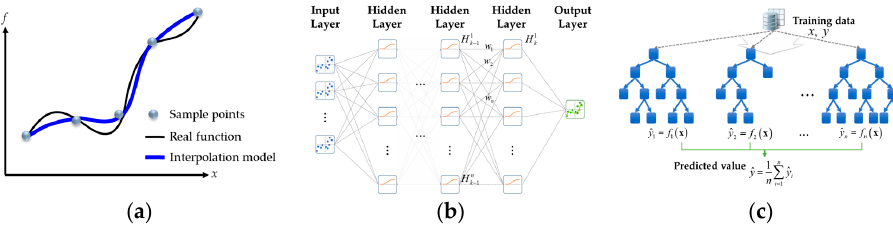
Figure 6. Conceptual diagram: ( a ) Kriging; ( b ) multilayer perceptron (MLP); ( c ) ensemble of decision tree (EDT). tree